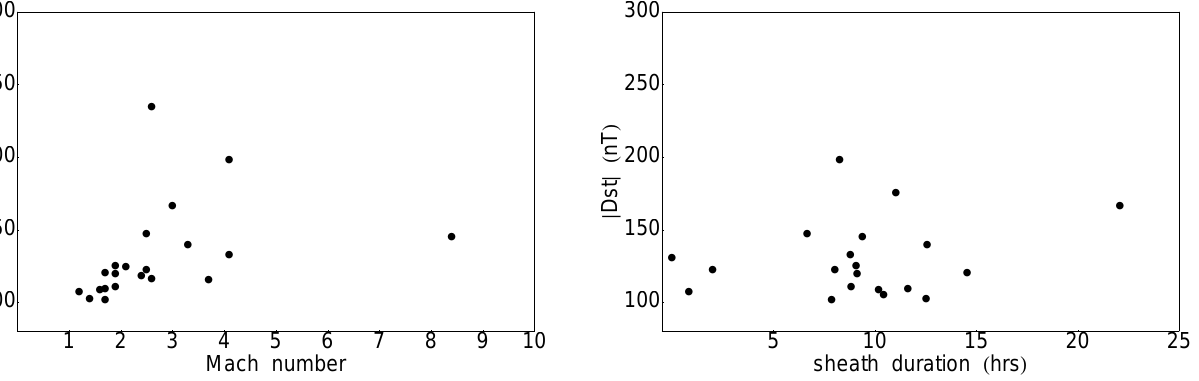
Figure 4. Scatter plots between Dst index and Wind/ACE ICME speed ( left , filled/empty symbols) and IP shock speed ( right ).